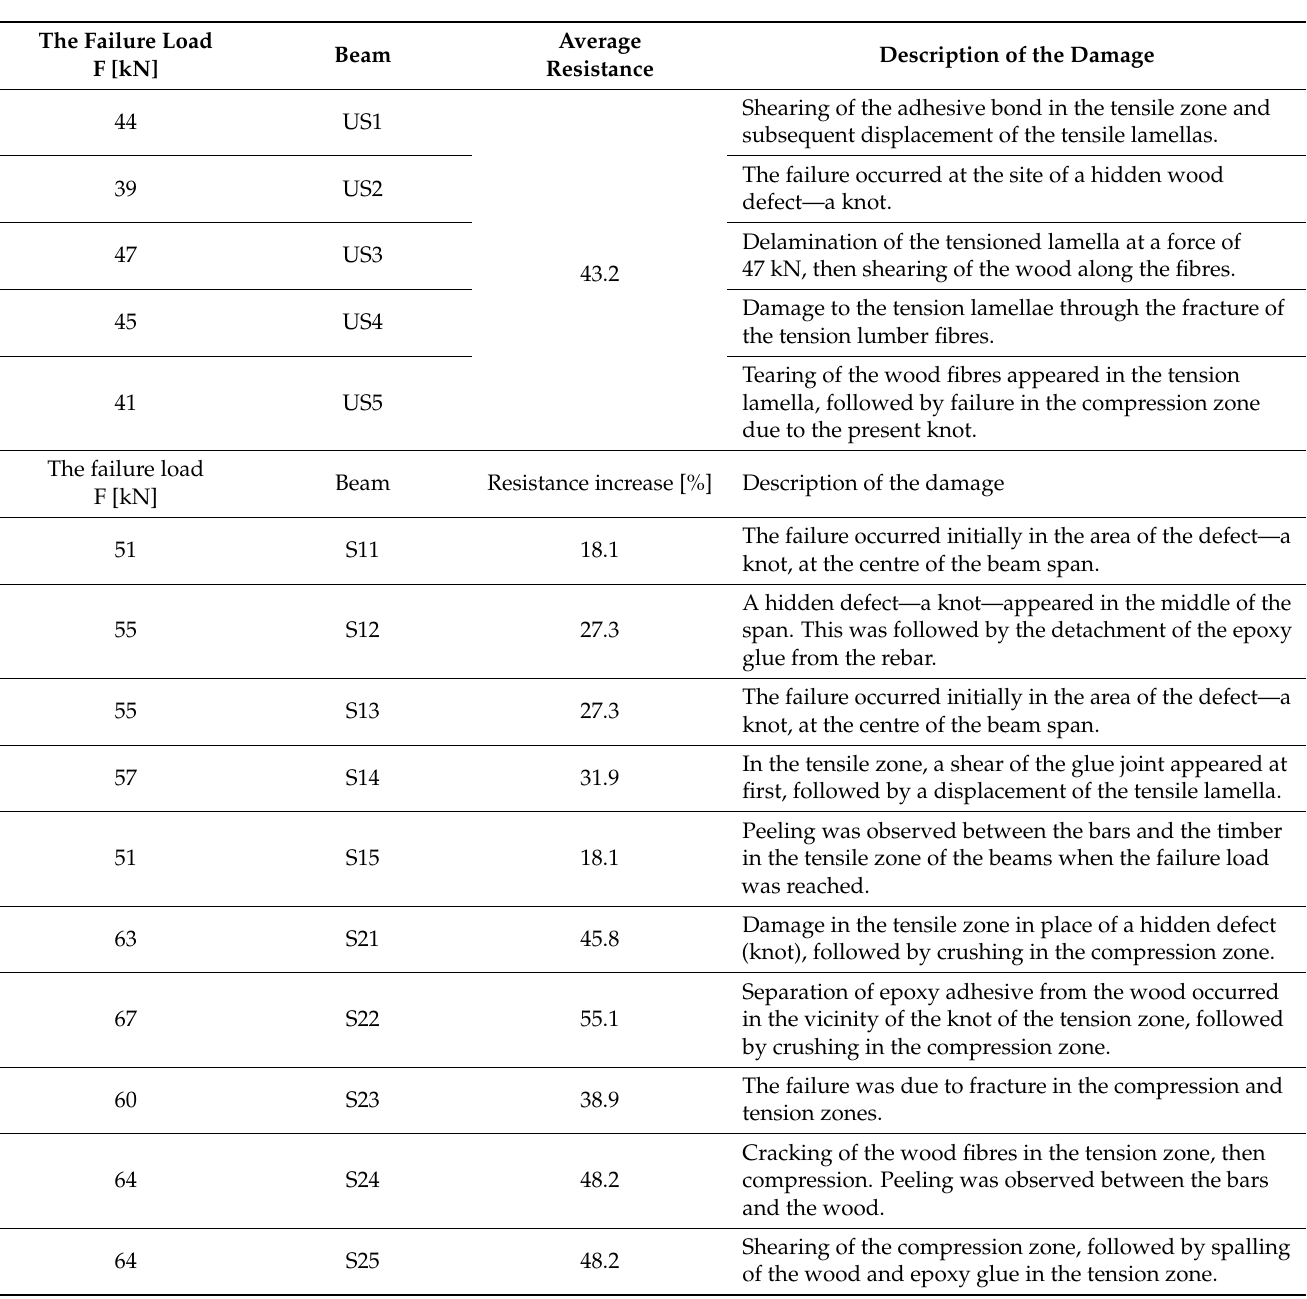
Table 2. The ultimate resistance and failure modes of tested